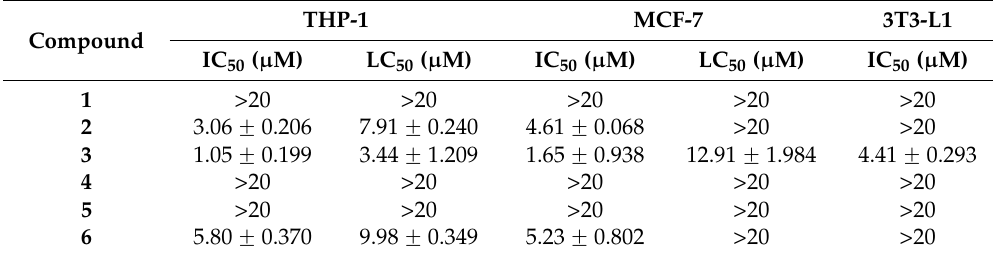
Table 2. Antiproliferative and cytotoxic effects of tested compounds 1 ´ 6 . IC 50 and LC 50 values were calculated using concentration-response curves generated from the results of WST-1 analysis and erythrosin B exclusion test, respectively. The values represent means ˘ SD of three independent experiments, each performed in